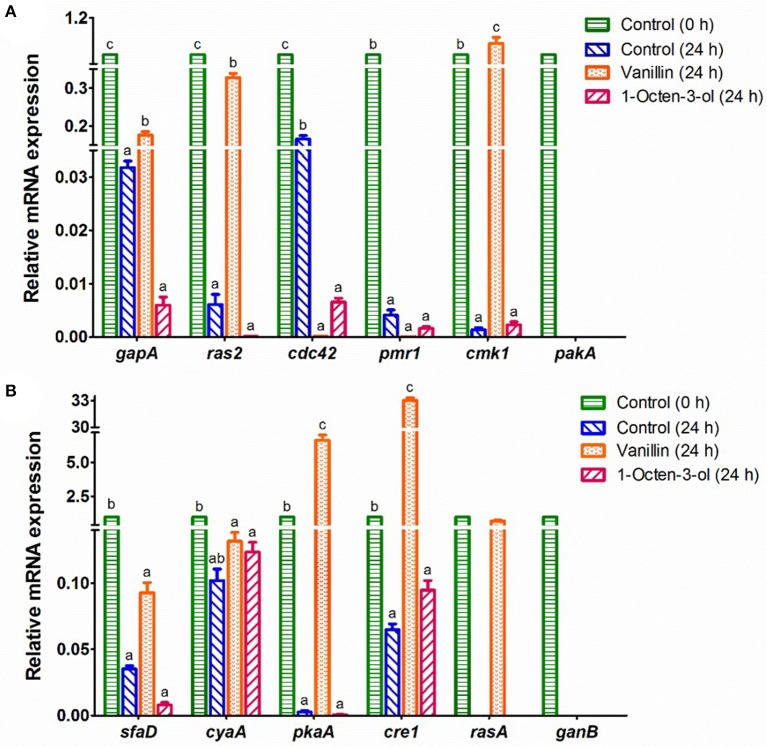
RT-qPCR analysis of the mRNA expression of genes which might relate to the germination of A. camphorata arthroconidia. (A)
gapA, ras2, cdc42, pmr1, cmk1, and pakA; (B)
sfaD, cyaA, pkaA, cre1, rasA, and ganB. The 18S rRNA gene of A. camphorata was used as an internal reference, and non-germinated arthroconidia (0 h) was used as control. Data were presented as mean ± SD. Inter-group statistical differences of the relative expression level of a specific gene were evaluated with Tukey's multiple-range test. P < 0.05 were considered statistically significant. Columns marked with different letters in a treatment group possess values of significantly difference (P < 0.05).